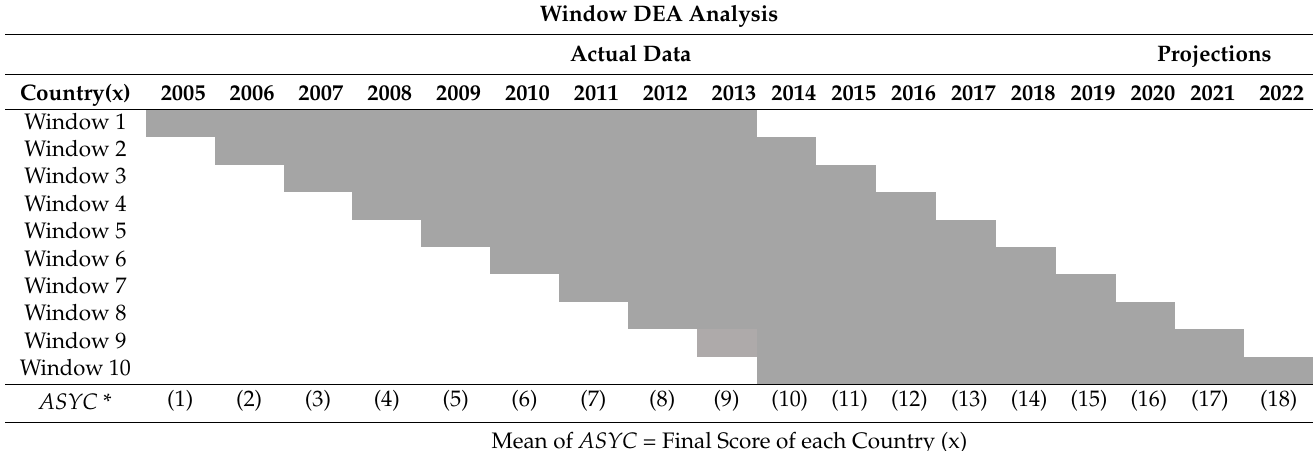
Table 3. Window DEA analysis representation for actual and projected dataset.